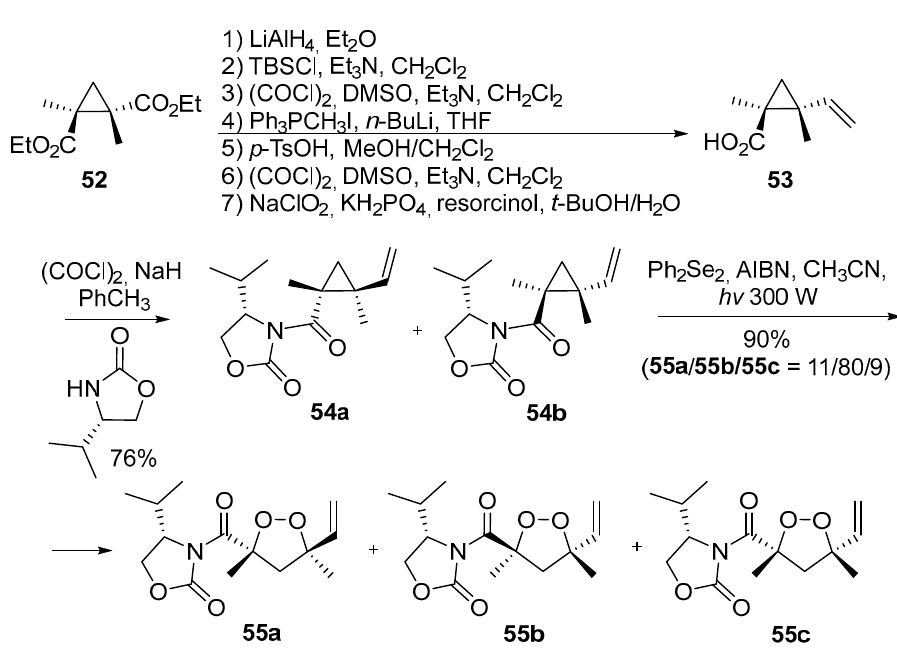
Scheme 7. Construction of 1,2-dioxolane fragment for epiplakinic acid F ( 8